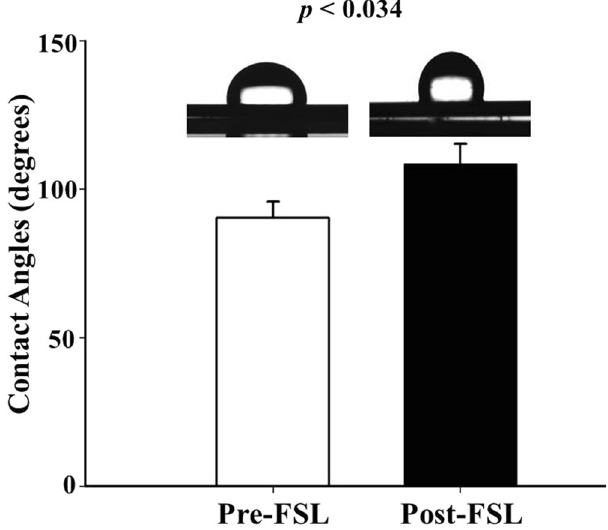
Figure 3. Measurements of surface wettability. Images of surface static contact angles of the stents were represented and analyzed. The indicated values are expressed as the mean ± SD (n =